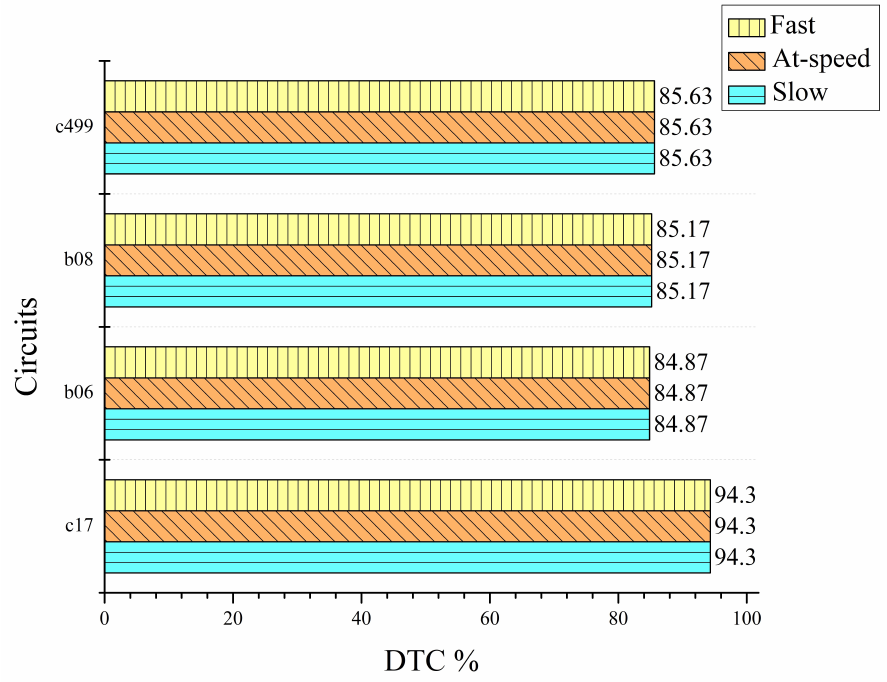
Figure 11. DTC percentage for different bechmark circuits tested at Slow, Fast and At-speed test clock period